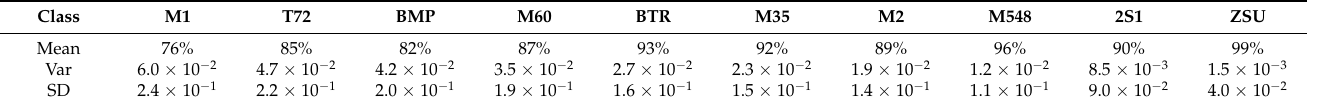
Table 4. EO-only ResNet18 intraclass variance (Var) and standard deviation